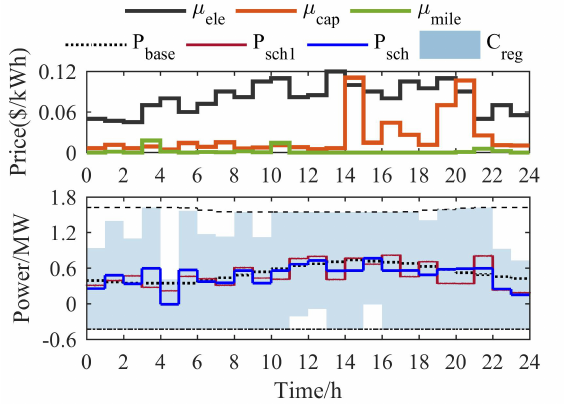
Figure 11. Scheduled power and regulation capacity in Case 2.